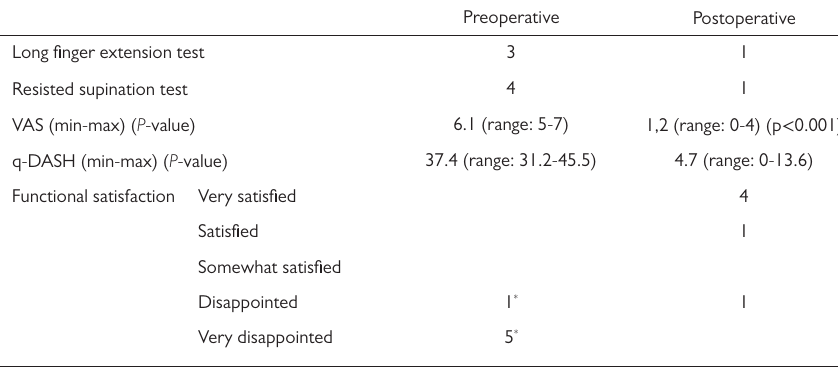
Table 3. Clinical Outcomes of Patients Refractory to Nonsurgical Treatment Who Were Offered Surgical